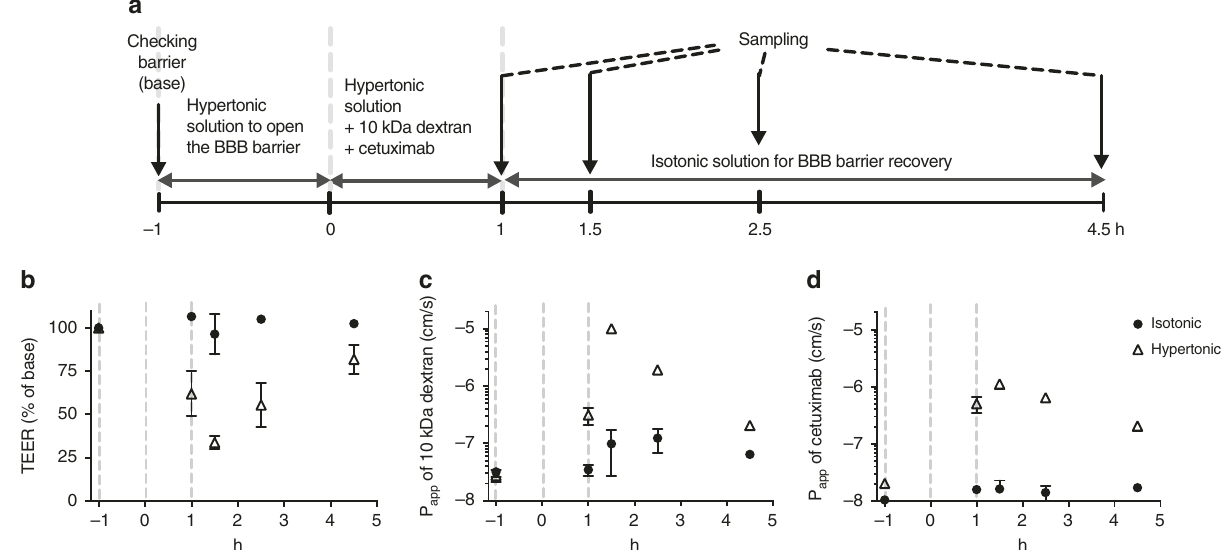
Fig. 4 Penetration of a therapeutic antibody through the BBB Chip using osmotic solutions. a Experimental design for assessing osmotic opening of endothelial barrier in the BBB chip, including the timeline for medium (hypertonic and isotonic) changes, and drug and tracer dosing, as well as sampling times. Barrier integrity of the BBB Chips under isotonic and hypertonic conditions as monitored by measuring TEER ( b ) or P app of 10 kDa dextran- conjugated to tetramethylrhodamine ( c ) or of the therapeutic antibody cetuximab ( d ). Data are presented as means ± SE, N = 2 representing